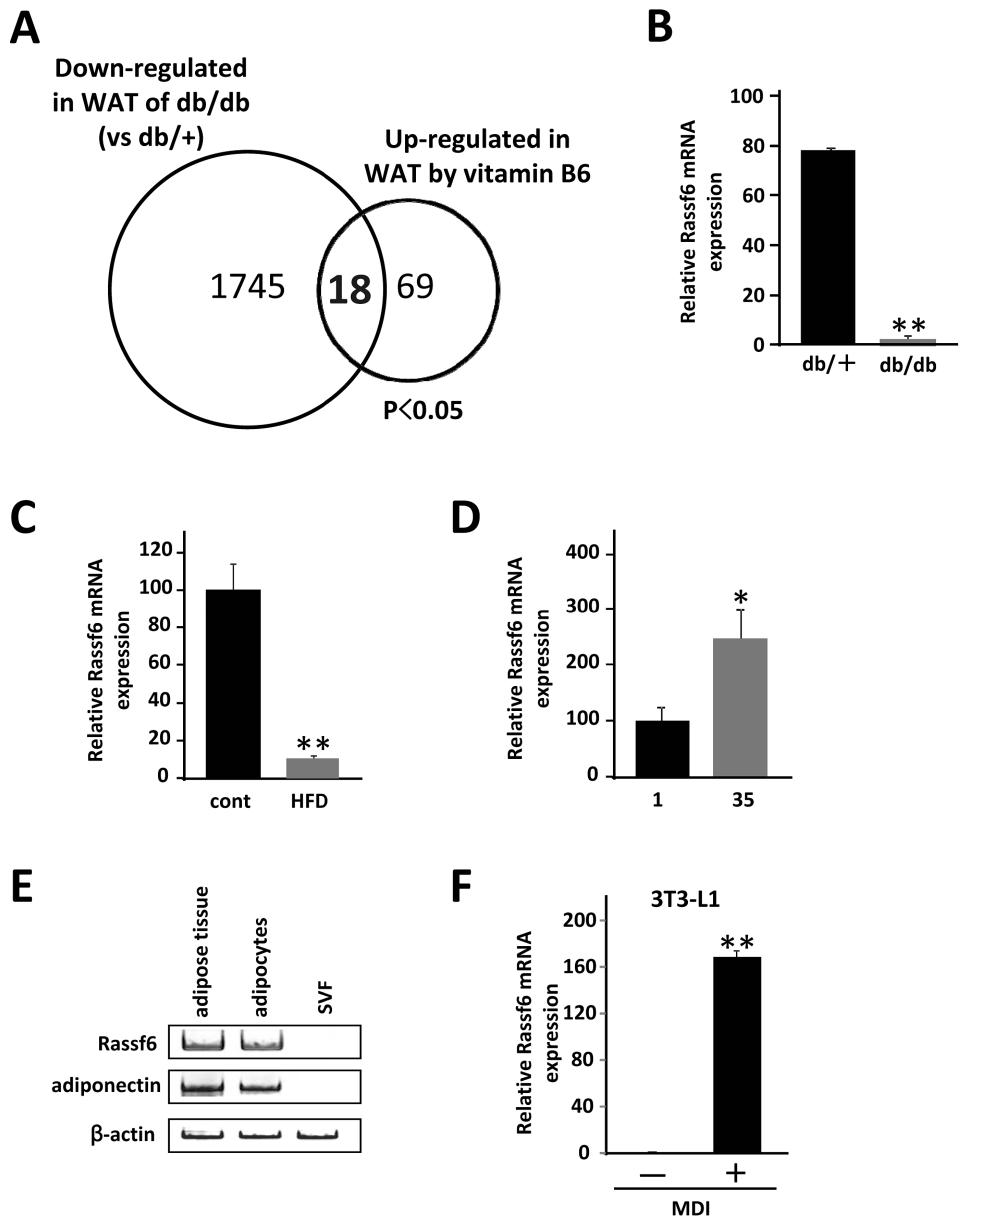
Figure 4. Analysis of two transcriptomes to isolate genes whose expression is downregulated by the interaction with macrophages. A , The Venn diagram shows genes that are downregulated in the db/db white adipose tissue and upregulated by vitamin B6 supplementation. Of a total 1745 genes downregulated in db/db adipose tissue, the expression of 18 genes was increased by dietary vitamin B6 ( p , 0.05). B , Total RNAs from individual mice (n=3) were subjected to quantitative PCR. Values are normalized to b -actin levels. ** P , 0.01 compared with that of control mice ( db/ + ). C , Mice were divided into two groups (n=4), and fed basal diet ( cont ) or high fat diet ( HFD ) for 8 weeks (n=4). The relative mRNA expression level of each gene was determined by quantitative PCR and normalized to b -actin level. ** P , 0.01 compared with that of mice with basal diet ( cont ). D , Total RNA from individual mice (n=12) in two groups was subjected to quantitative PCR to examine RASSF6 mRNA expression level. All values are normalized to b -actin levels. * P , 0.05 compared with that of 1 mg/kg PN ( 1 ). E , Mature adipocytes and SVF were isolated from white adipose tissue of HFD mice as described under ‘‘Materials and Methods’’. The level of adiponectin transcript was used as a control for mature adipocytes. F , 3T3-L1 preadipocytes were treated with MDI for 48 h and differentiated into mature adipocytes as described under ‘‘Experimental Procedures’’. Total RNA was extracted and subjected to quantitative PCR to examine RASSF6 mRNA expression level.